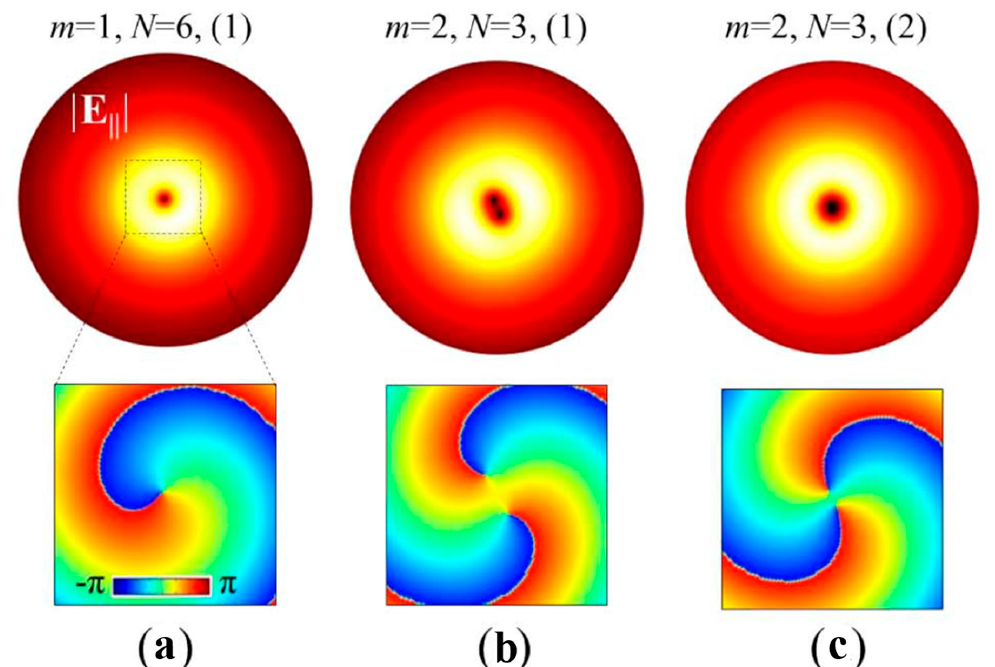
Figure 20. The FEM simulations of the MIM-PVL architecture. The upper column of ( a – c ) shows the | E || | field in the x - y plane located 800 nm below the hole for the PVLs of m = 1, N = 6; m = 2, N = 3; m = 2, N = 3, respectively. N denotes the numbers of spiral turns. The subjacent column displays the corresponding arg( E x ) fields. From [64]; reprinted with permission. Copyright Optical Society of America, 2014.